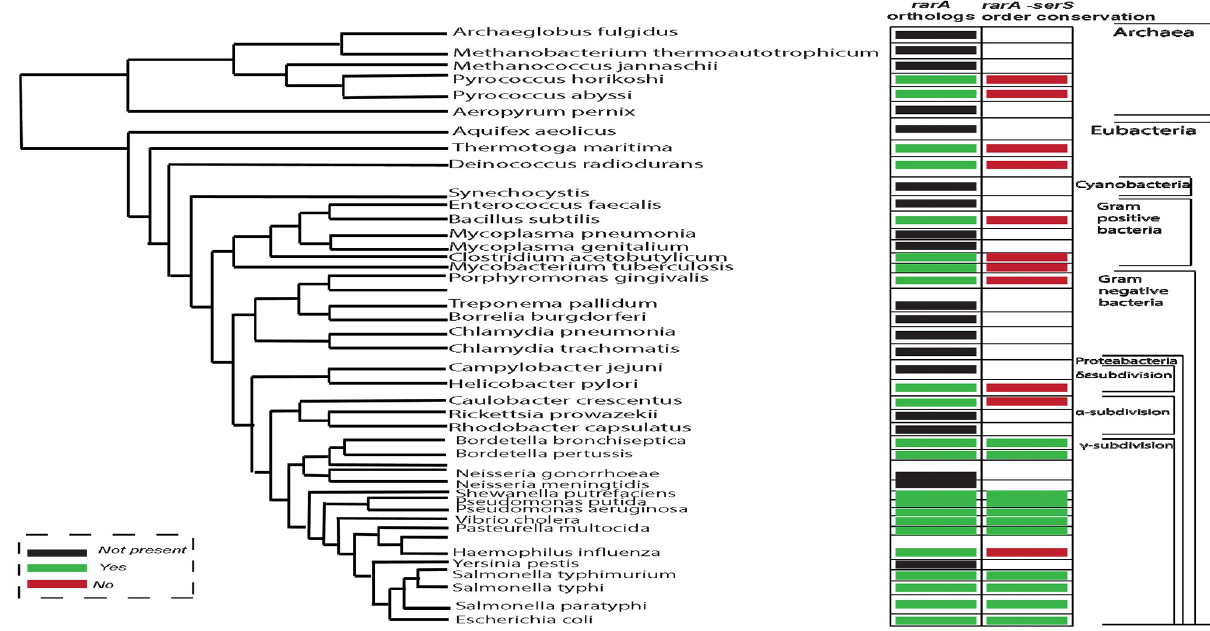
Fig 3. Multiple genome sequence alignment to identify orthologs of rarA , and the conservation of its genetic context in other organisms. Conservation of proximity between rarA and serS genes in γ -proteobacteria class was identified.